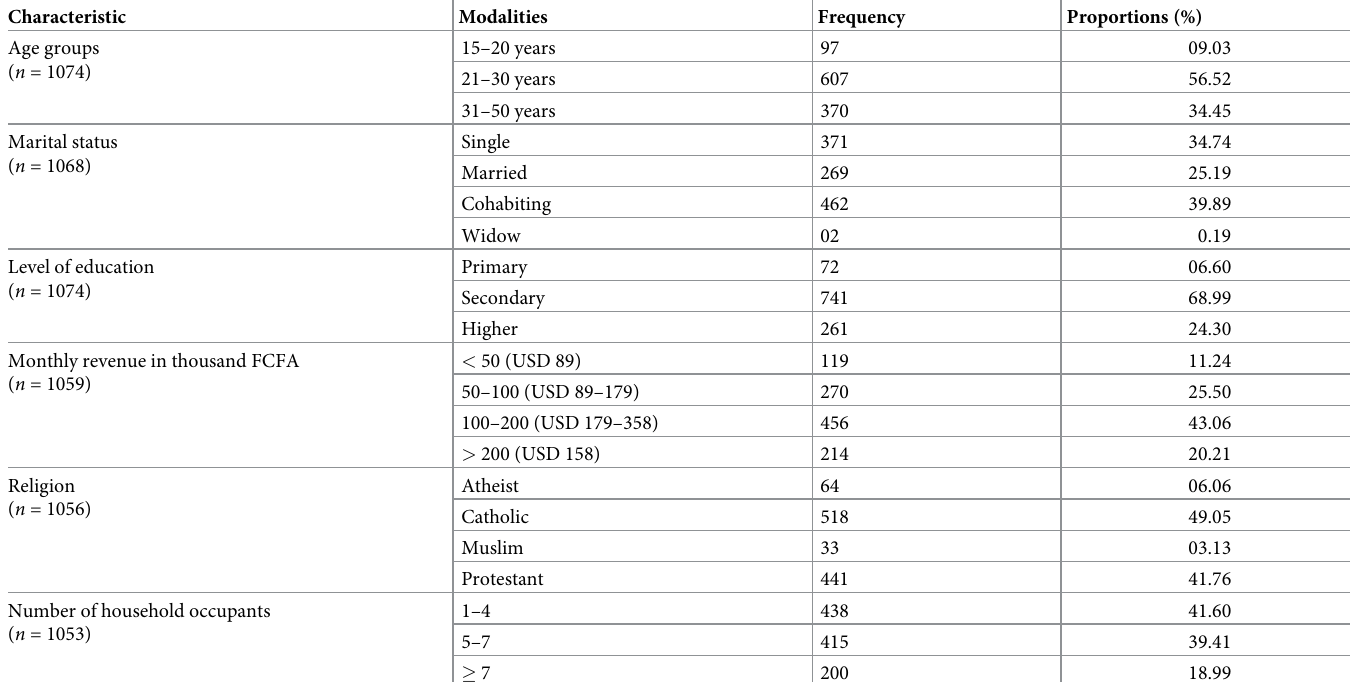
Table 1. Sociodemographic characteristics of